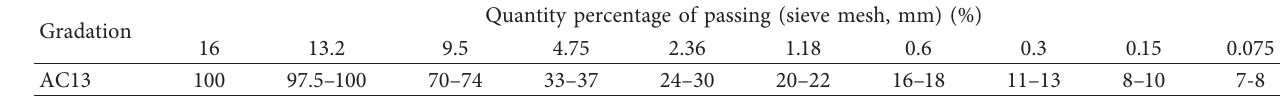
Table 2: Gradation of the asphalt mixture.